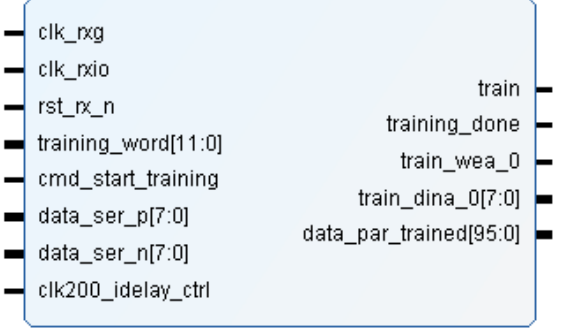
Figure 4. Image_rx block diagram.